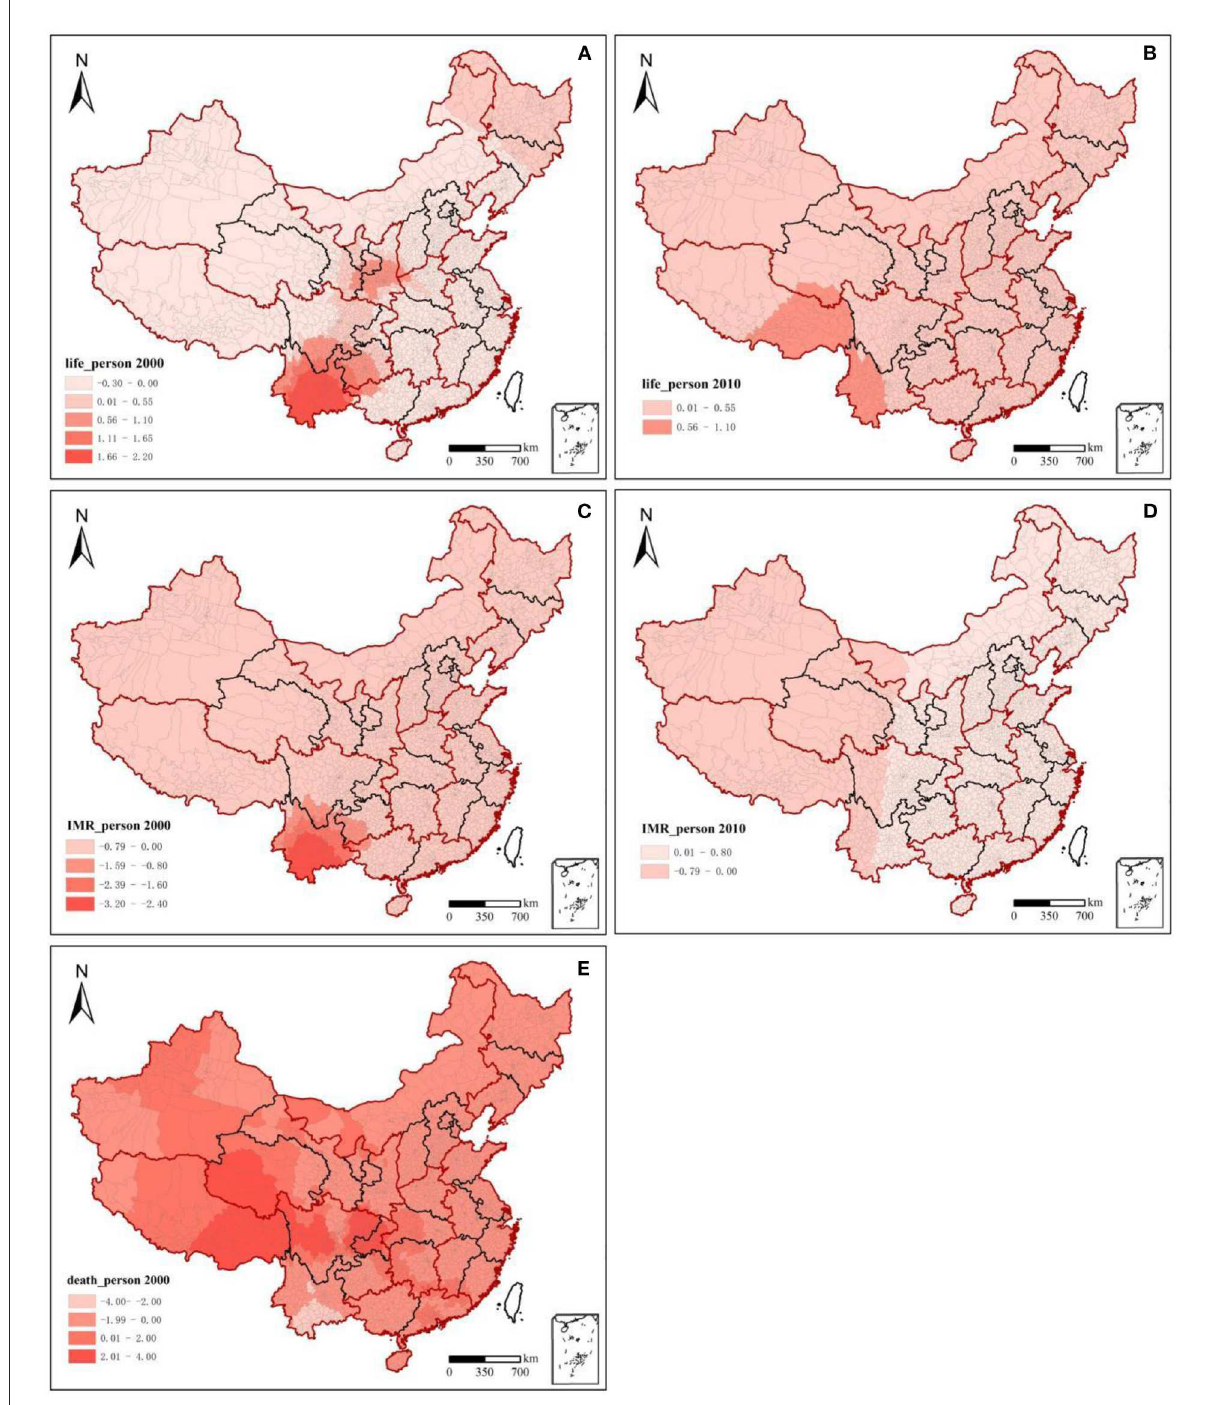
FIGURE5 Spatial patterns of health technicians influencing population health, 2000–2010. Beta coefficients ( p < 0.05); white blank: values were not statistically significant; Taiwan, Hong Kong, and Macao were excluded from the